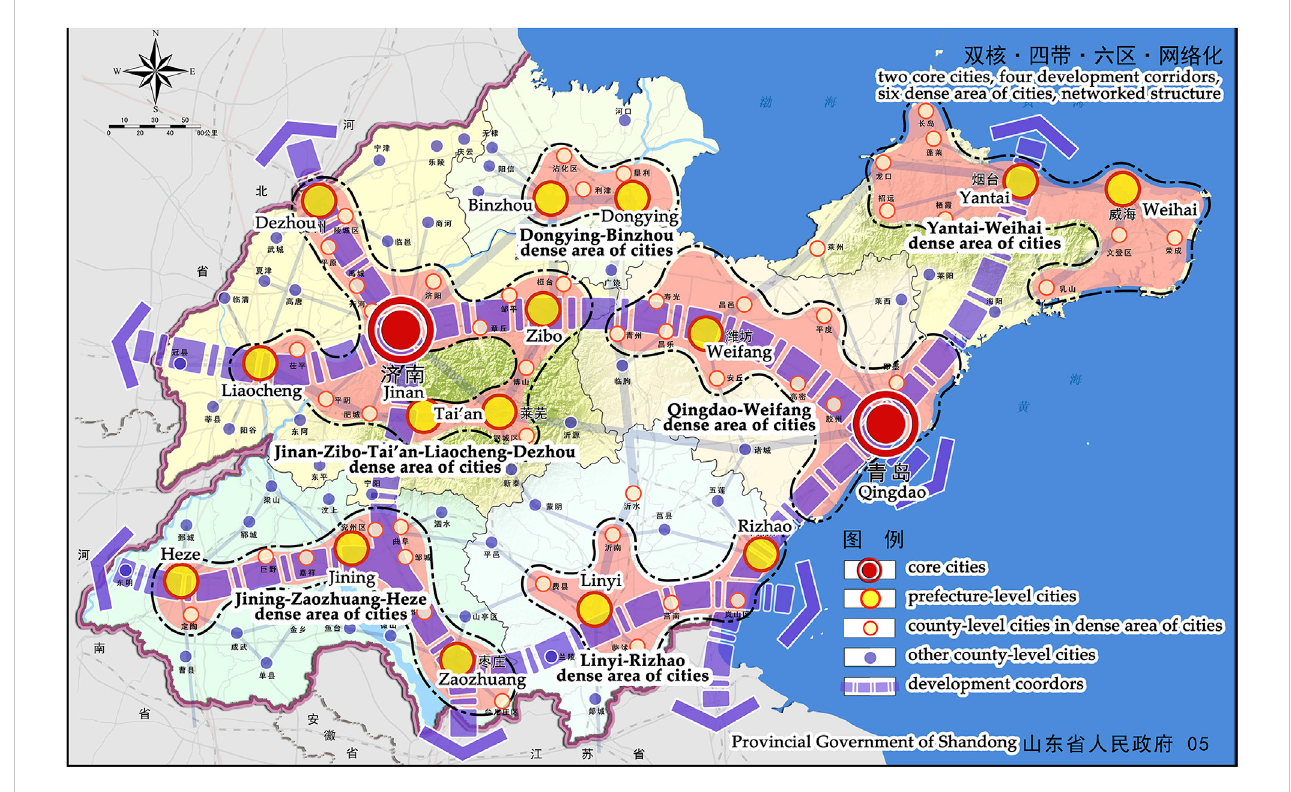
FIGURE 7 Spatial layout of cities in Urban System Planning of Shandong Province (2011 –